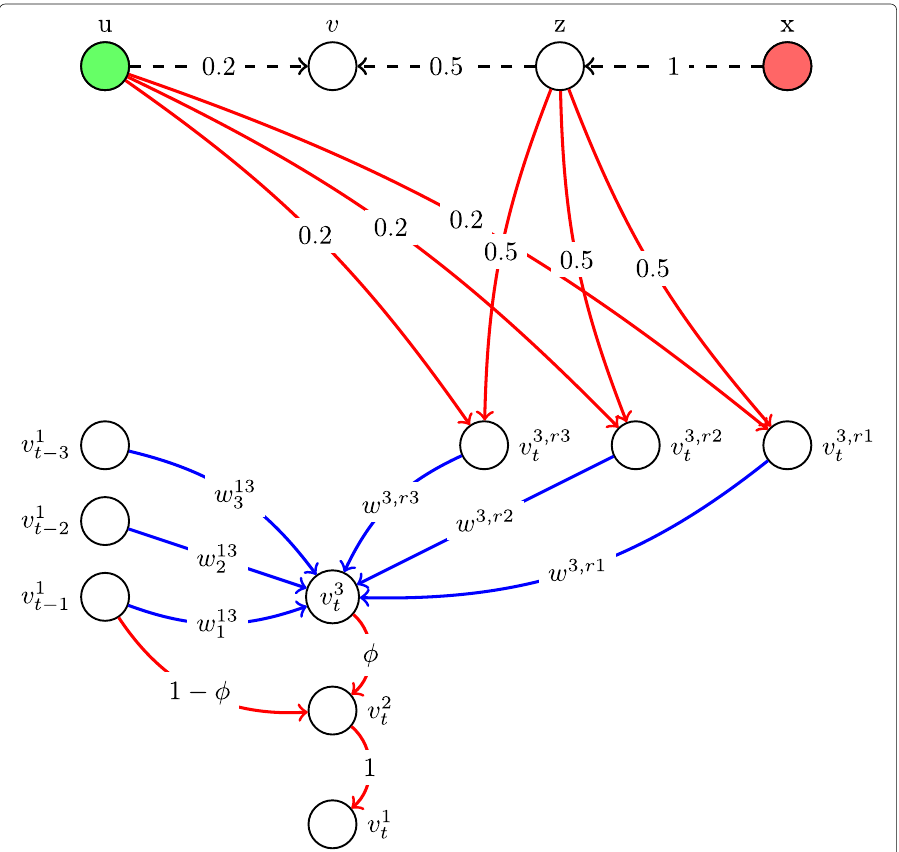
Fig. 8 Serialization of a diffusion graph under a competitive model with time-varying activation-threshold